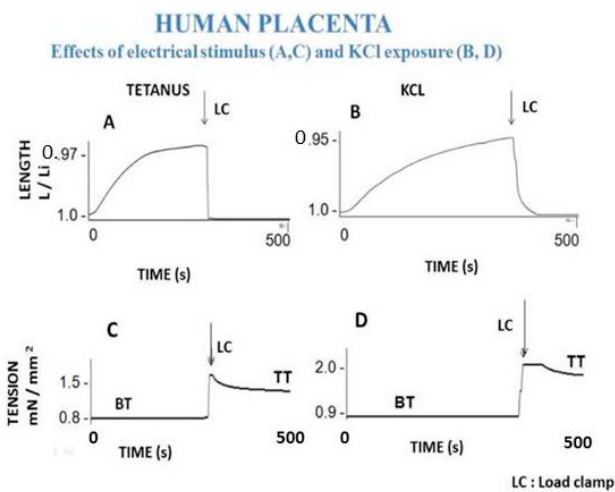
Figure 3. Basic contractility of human placental stem villi. Panels A and C : Effect of tetanic electrical stimulation on placental stem villi. Panel A : placental villi shortening. Panel C : tension. When the shortening of the placental stem villi reaches a plateau, its value is at its maximum. The arrow marks the time at which tension is suddenly increased by means of a load clamp, placing the placental villi under isometric conditions. Active tension is the difference between total isometric tension and resting passive basal tension (BT). Panels B and D : Effect of 0.05 M KCl on placental villi. Panel B : placental stem villi shortening length. Panel D : tension.